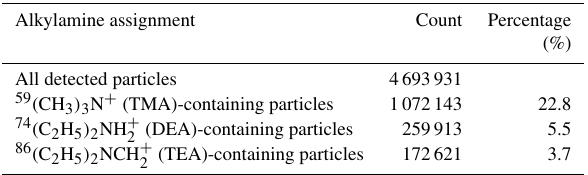
Table 1. Summary of the major species of detected amine- containing particles and fragments in September in Nanjing, China.